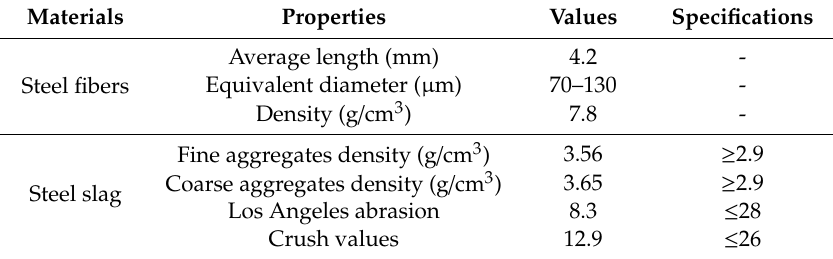
Table 2. Properties of steel fibers and steel